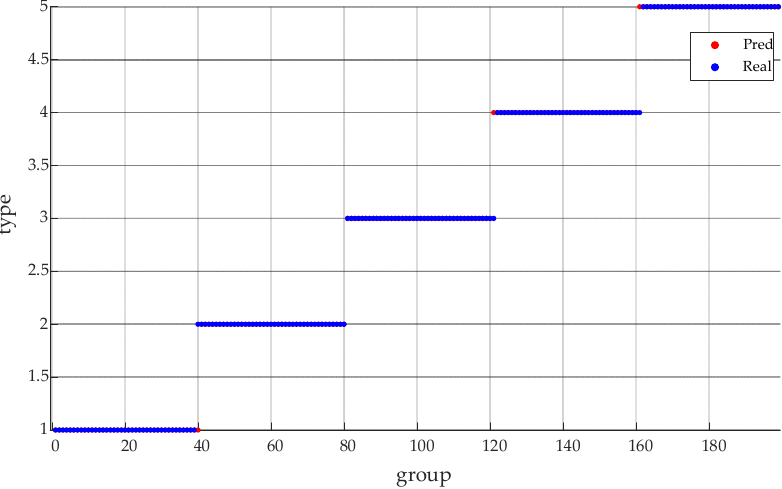
Table 4. Test accuracies for each type of occupancy.